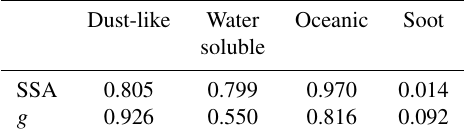
Figure 2. (a) RGB image of flight data from 4 September 2014 (ang20140904t204546). Adapted from Thompson et al. (2015). (b) CH 4 enhancement value α (ppm × m) obtained by the MF method. An emission source is shown in the solid red box and the background region near the target for the MF calculation is indicated by the dashed green box. Table 1. Optical properties of basic aerosol types (WCRP,